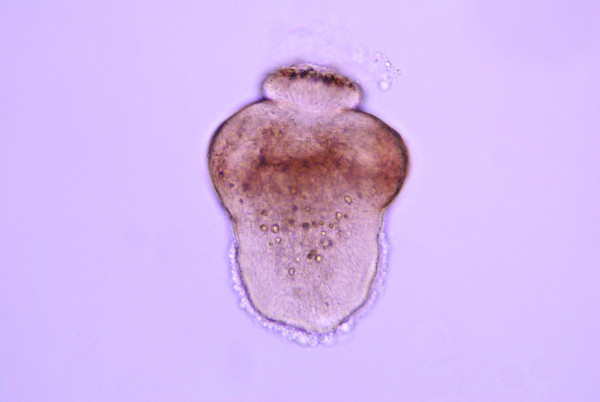
Developmental stage of a metacestode with completely organized hooklets and everted rostellum.